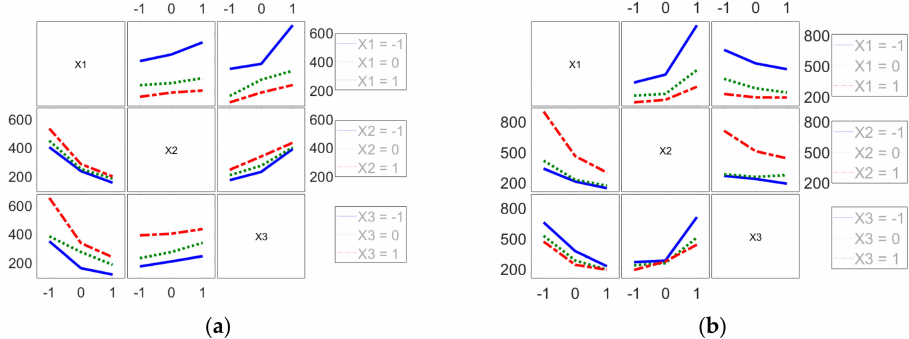
Figure 7. Plots of the interactions of the design variables. ( a ) Convex shape and ( b ) saddle